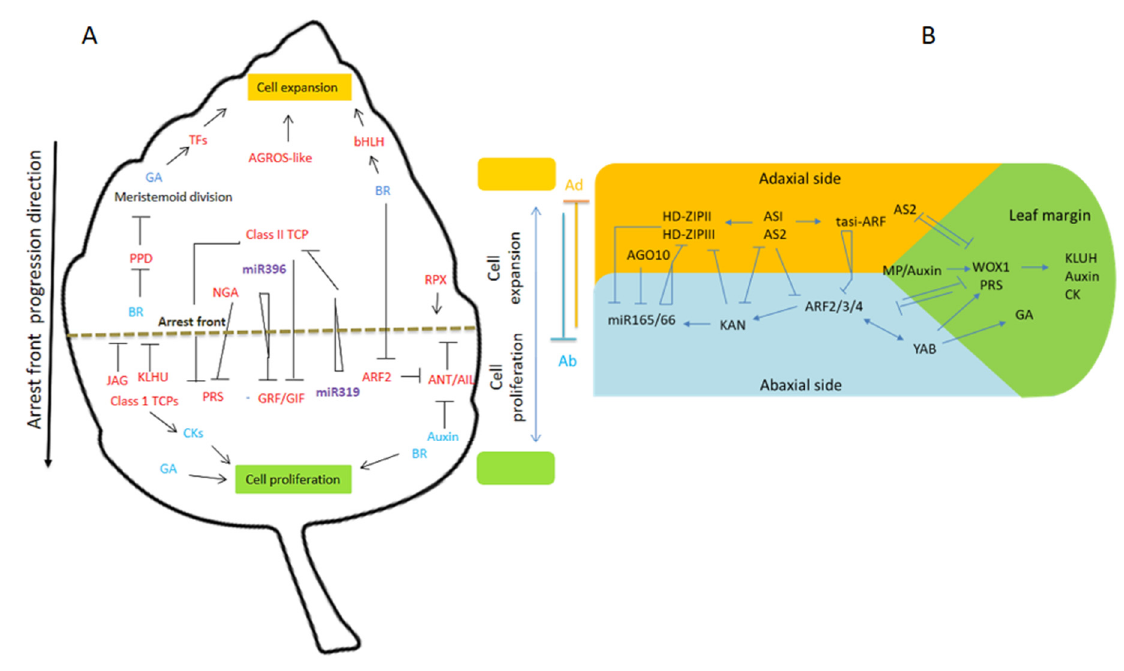
Figure 2. Regulation of Arabidopsis leaf proliferation and cell expansion transition. ( A ) the cell cycle arrests the front migration basipetal growth gradient from the apex to the base of the blade petioles, which is a process that is promoted by miR319-TCP modules and repressed by miR393-GRF modules. The gradients of miR319 and miR396 are complementary to TCP and GRF expression. TCP and NGA repressed the blastozone activity. During intercalary growth, the GAs and BRs promote both cell proliferation and expansion (positive and negative regulations are indicated by pointed and T-shaped arrows). Red, genes; blue, hormones; purple, small RNAs. ( B ) Shortly after its initiation, the young leaf primordium has three regions: adaxial, abaxial, and leaf marginal regions. These regions are determined by the region’s specific transcription factors, such as HD-ZIP III, KANADI, and PRS WOX1, involving multiple negative feedback loop mechanisms. For the sake of clarity, all the interactions are not shown here. Adaxial-abaxial polarity is determined by highly interconnected gene networks. In this network, tasi-ARF limits abaxial determinants and AUXIN RESPONSE FACTORS ARF3 / ARF4 to the bottom side. In addition, miR165 / 166 restricts the expression of adaxial determinants HD-ZIPIII to the top of the leaf (the positive and negative regulations are indicated by pointed and T-shaped arrows, respectively).